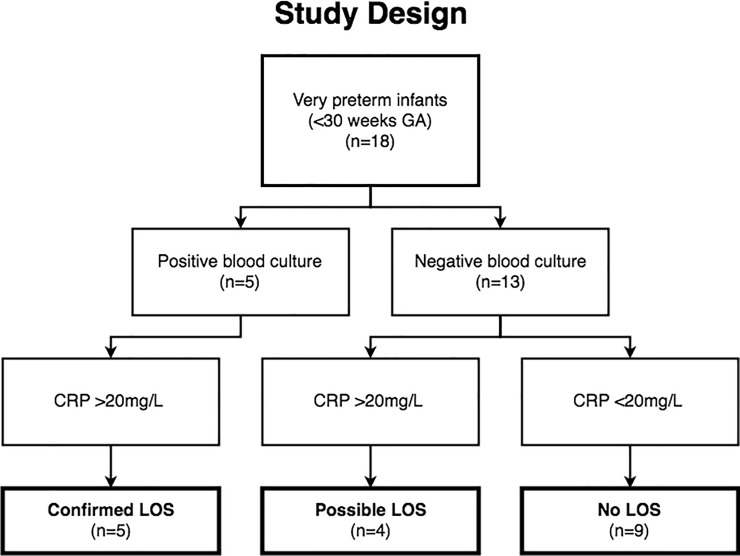
Study design.Summary of samples included in bioinformatics and statistical analyses (bolded boxes). Infants were classified as having confirmed late-onset sepsis (LOS), possible LOS or no LOS based on blood culture and CRP measurement results within 72 hours of blood culture.